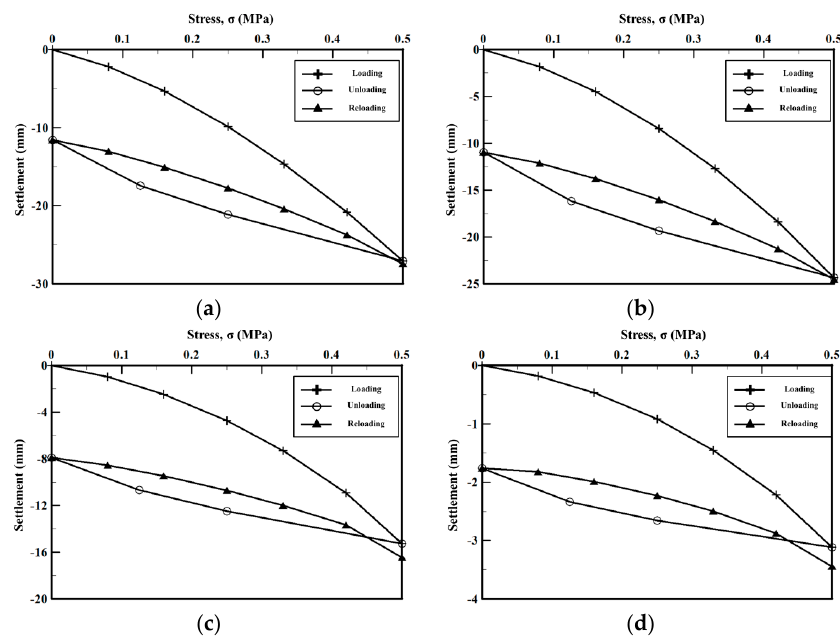
Figure 5. Stress–settlement curve according to the loading-plate size: ( a ) 762-mm loading plate; ( b ) 300-mm loading plate; ( c ) 150-mm loading plate; ( d ) 50-mm loading plate.